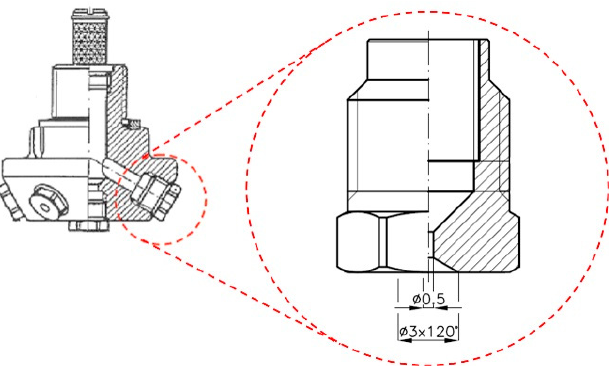
Figure 6. Technical sketch of the employed nozzle type (NWMO14 by Bettati Antincendio s.r.l.), with a detail of the injector.